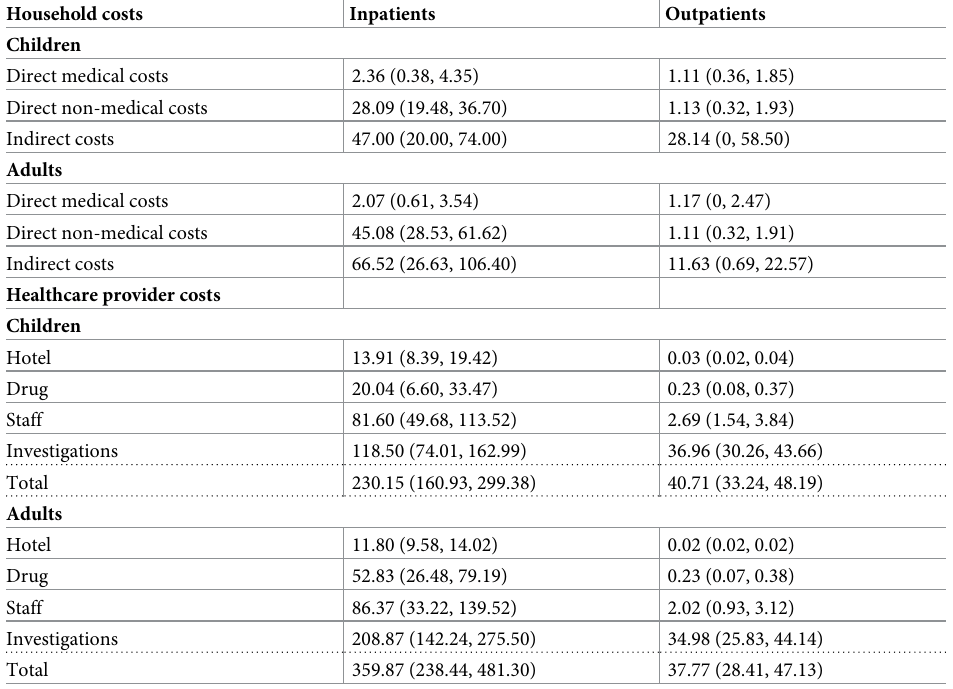
Table 2. Mean (95% confidence bounds) household and healthcare provider costs (2020 US dollars).